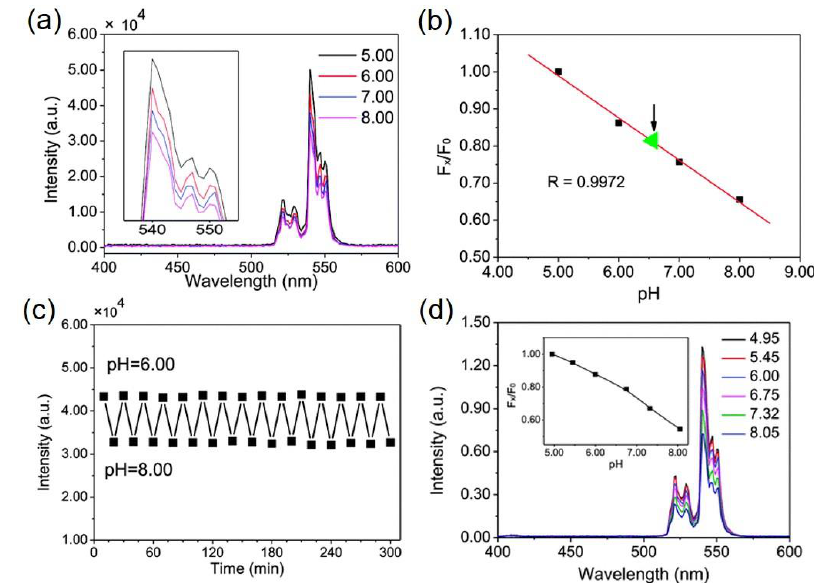
Figure 4. ( a ) The upconversion spectra of the graphene oxide–PEI-NaYF 4 ; Er 3+ /Yb 3+ film in buffer solutions upon excitation at 980 nm; ( b ) ratio of green emission intensity at pH 5 to green emission intensity at other pH values; ( c ) repetitive cycles of the pH-sensor between pH 6.00 and pH 8.00, showing response time; and ( d ) upconversion spectra of graphene oxide–PEI-NaYF 4 ; Er 3+ /Yb 3+ in urine of mice. Inset shows the ratio of green emission intensity at pH 5 to green emission intensity at other pH values plotted against the pH values in diluted urine (reproduced from Ref. [32] with permission from the PCCP Owner Societies).